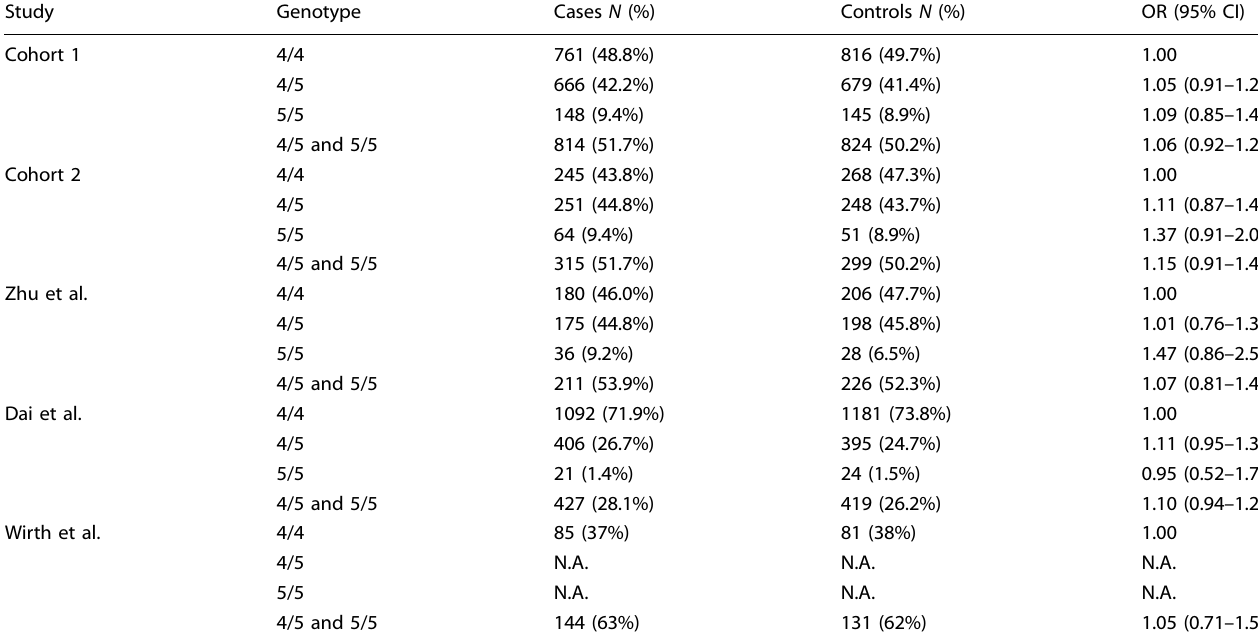
Table 1. Genotype distributions of the different cohorts included in the meta-analysis. Study